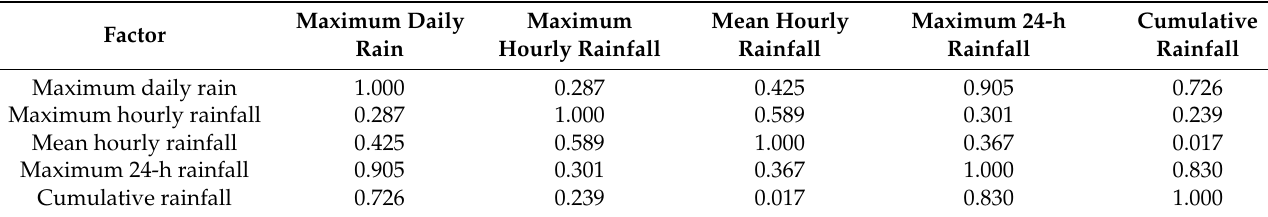
Table 11. Pearson’s correlation coefficient